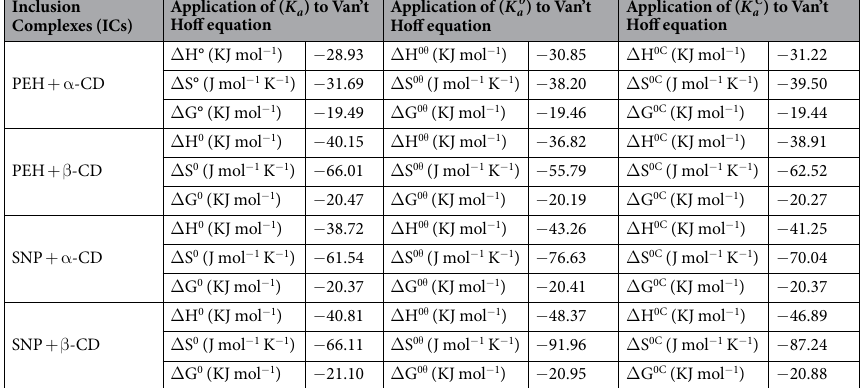
Table 4. Thermodynamic parameters ( Δ H°, Δ S°, Δ G°) calculated, using the association constants ( K obtained from Benesi-Hildebrand method, nonlinear Program, program based mathematical calculation of non-linear changes in the conductivity data respectively. Mean errors in variables are as follows: Δ H 0 = ± 0.01 kJ mol − 1 ; Δ S 0 = ± 0.01 J mol − 1 K − 1 ; Δ G 0 = ± 0.01 kJ mol − 1 ; Δ H 0 θ = ± 0.01 kJ mol − 1 ;